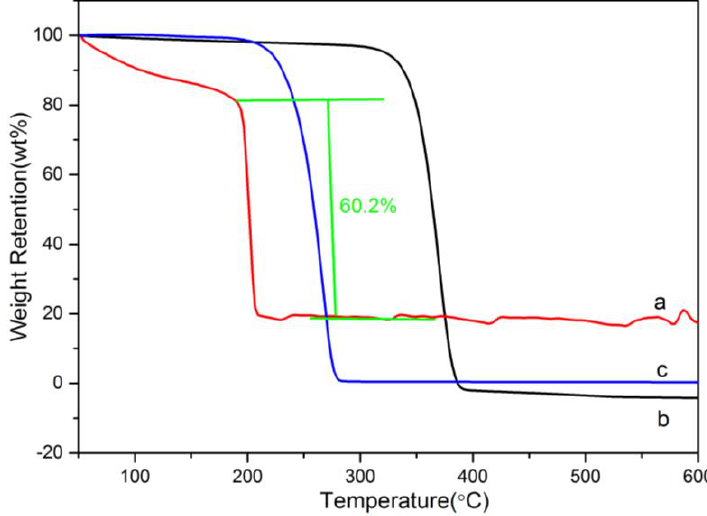
Figure 7. TGA (Thermogravimetric Analysis) curve of ( a ) GO-ZnO, ( b ) PLLA, and ( c ) GO-ZnO-PLLA.